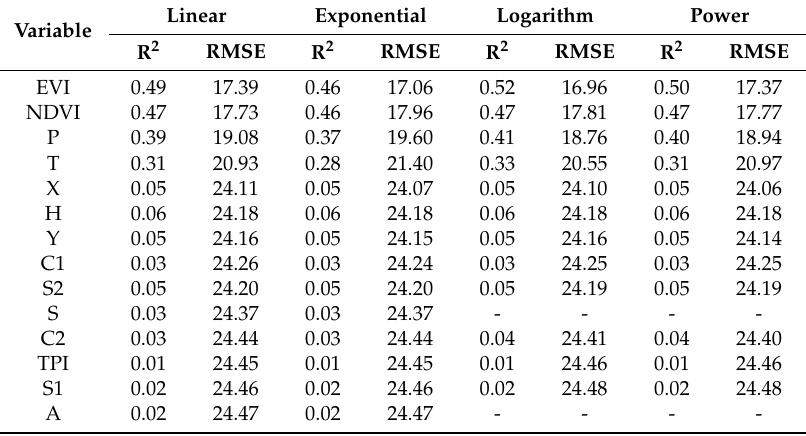
models do not. Based on the model-fitted 10-fold cross-accuracy validation and optimum inversion models, the best-fitted models constructed based on each variable are listed in Table 5. Table 3. Validation results obtained through 10-fold cross-validation for the grassland cover models based on a single factor.